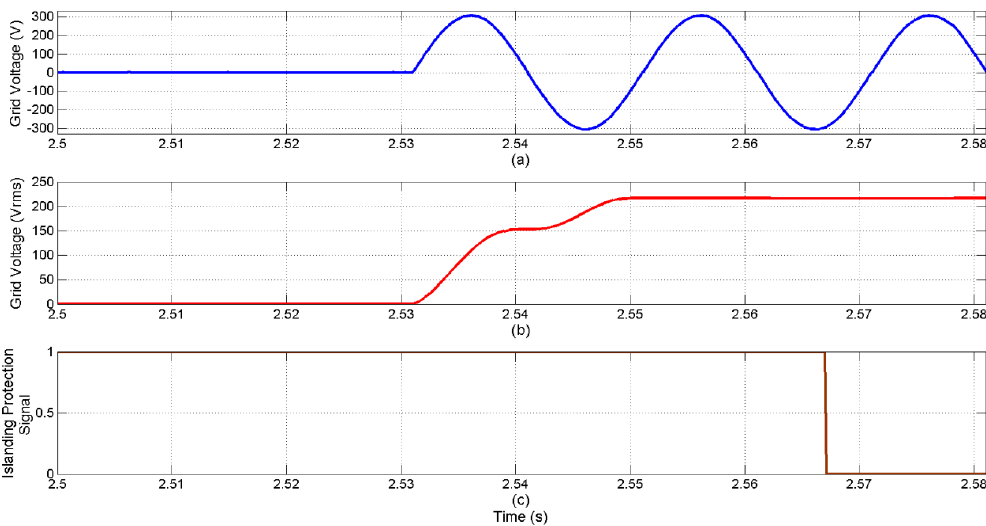
Figure 16. The waveform of the grid voltage when the power grid is powered up again. ( a ) Grid voltage [V] ( b ) Grid voltage [Vrms] ( c ) Islanding protection signal.